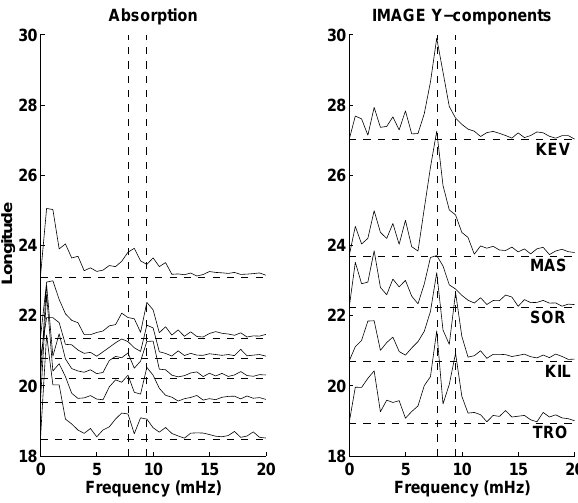
Fig. 5. Time series of Event 2 in absorption and magnetic Y - component. East is at the top of each plot.